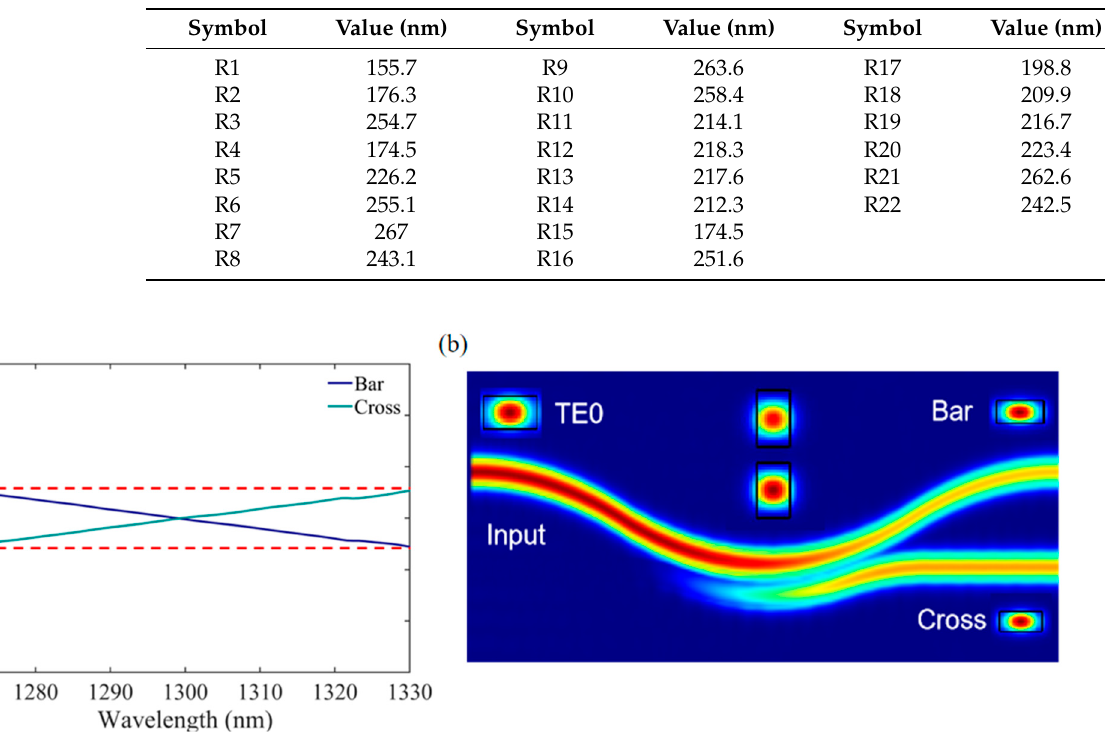
Figure 5. ( a ) Simulated transmission curves of the PSO optimized device with silicon columns introduced. ( b ) Simulated Light field profile of the PSO optimized device obtained with TE0 mode excited.